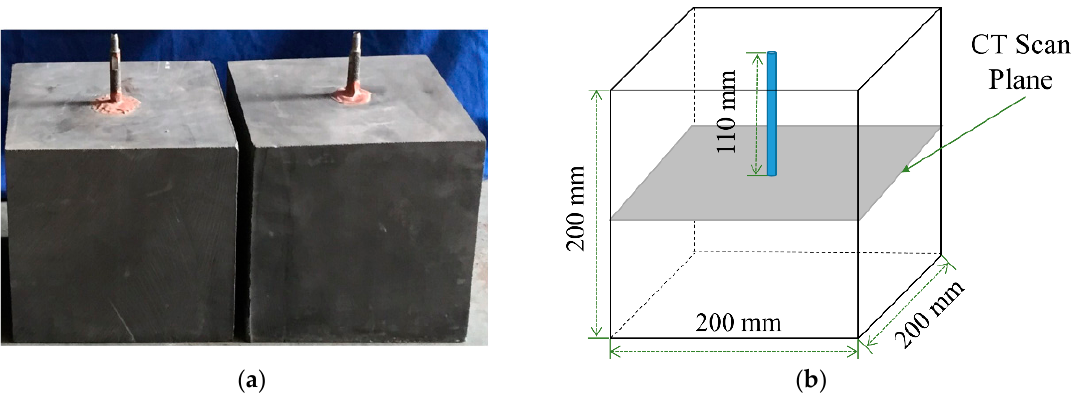
Figure 2. ( a ) Samples used in fracturing tests. The sample dimension is 200 mm × 200 mm × 200 mm cubic with a central borehole which length is 110 mm; ( b ) illustration of computed tomography (CT) scan plane. The scanning planes are perpendicular to the borehole direction. Table 1. Petrophysical properties of the Longmaxi shale.